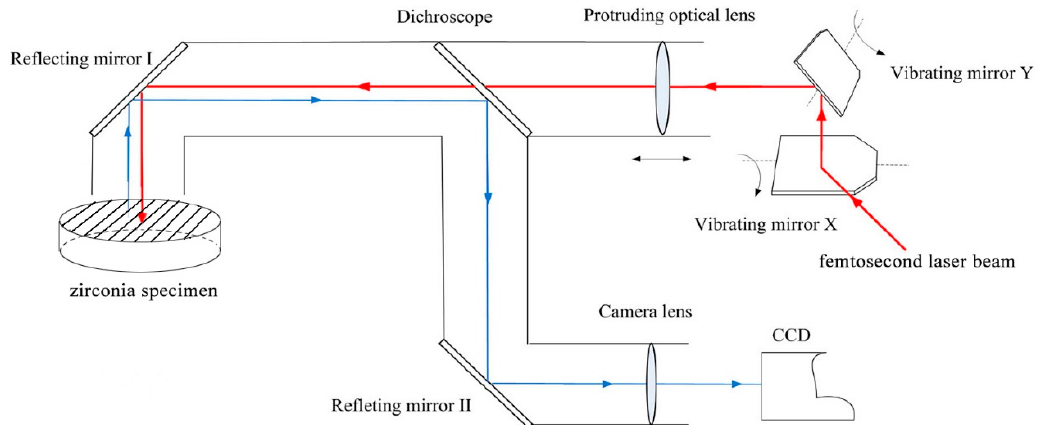
Figure 1. Schematic of the FSL surface treatment system and laser trajectory during surface treatment of the specimen. The red line indicates the propagation path of the FSL in the system, and the blue line indicates the light from the surface treatment result received by the charge-coupled device, which monitored the real-time processing results as the laser processed the specimen surface.